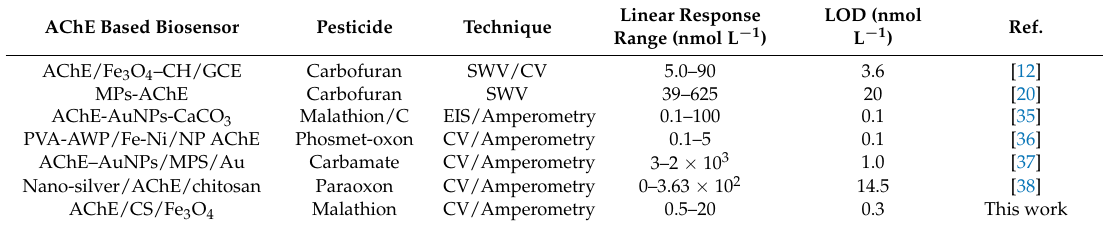
Table 1. Comparison of the analytical performance of sensors for the detection of pesticide residues. AChE Based Biosensor